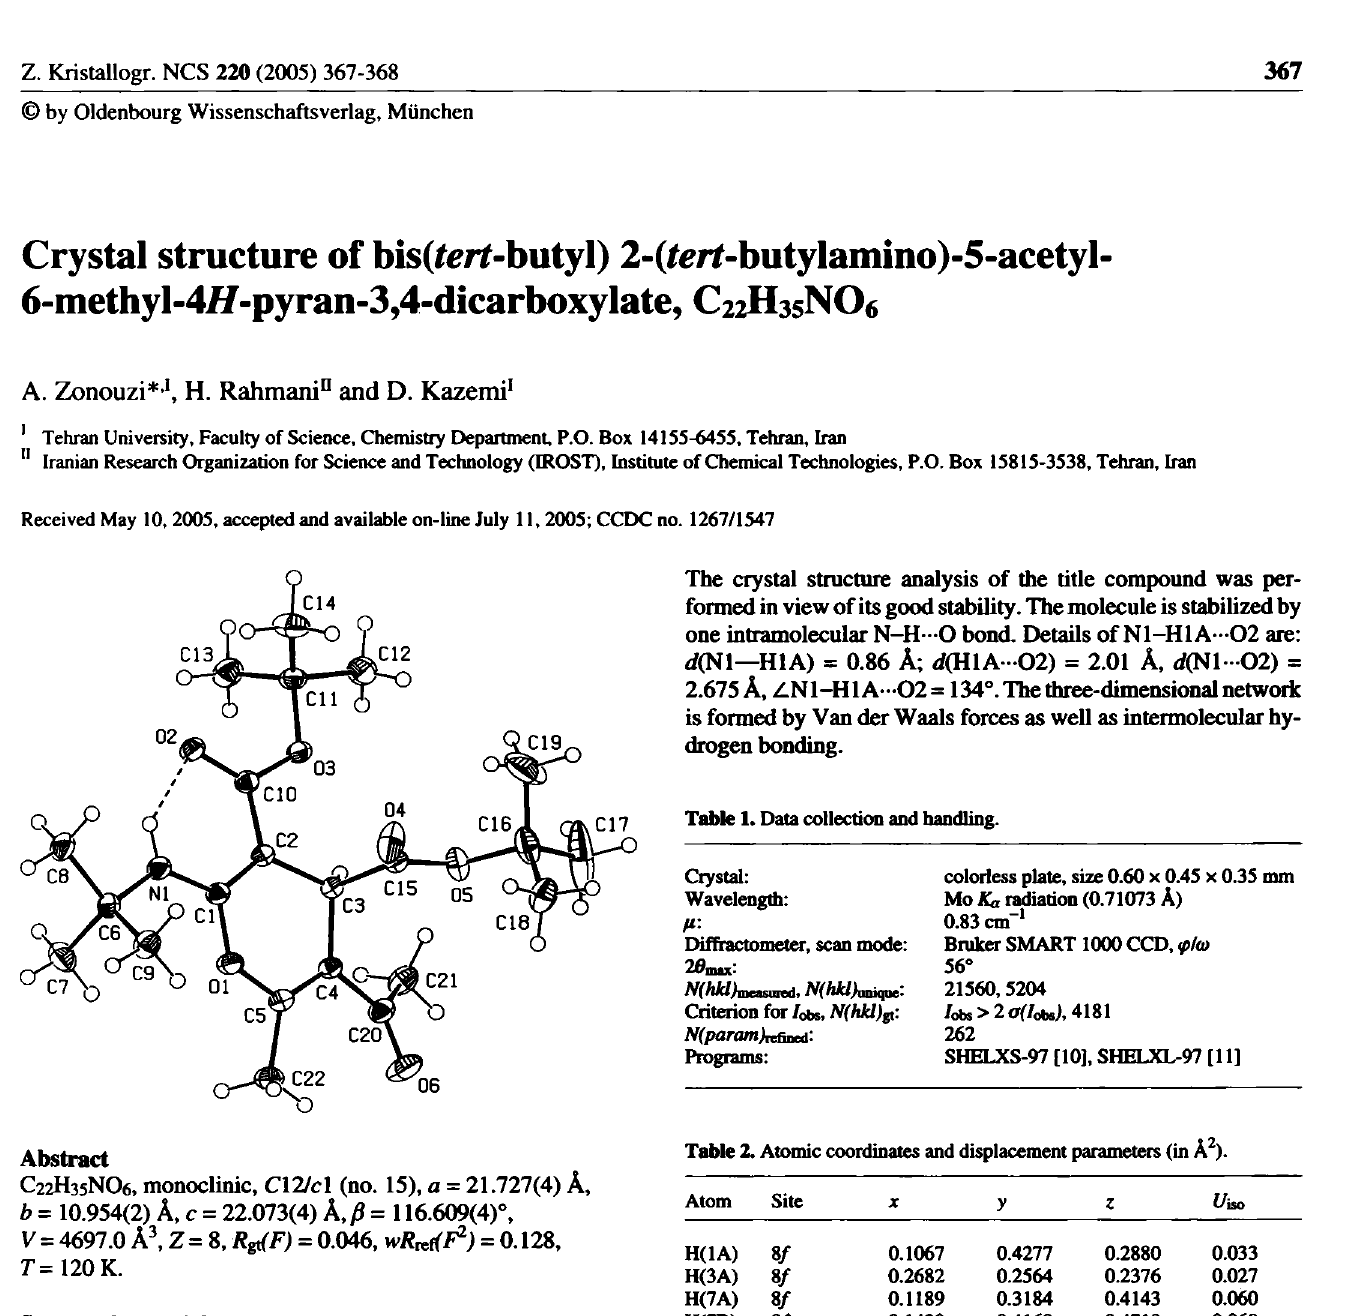
Table 2. Atomic coordinates and displacement parameters (in A 2